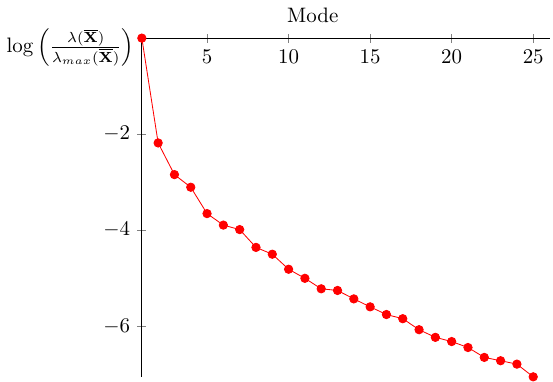
Figure 11. Singular values of X verifying λ ( X ) > (cid:101) POD λ max ( X )